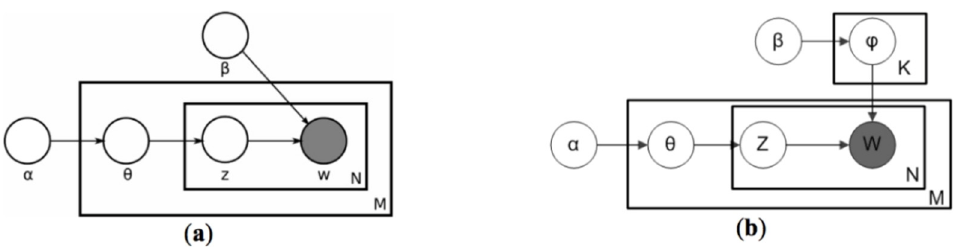
Figure 3. Latent Dirichlet Allocation (LDA) process: ( a ) LDA model represented by plate notation; ( b ) LDA with Dirichlet-distributed topic-word distributions. Source: Adapted from Saura and Bennett [52].